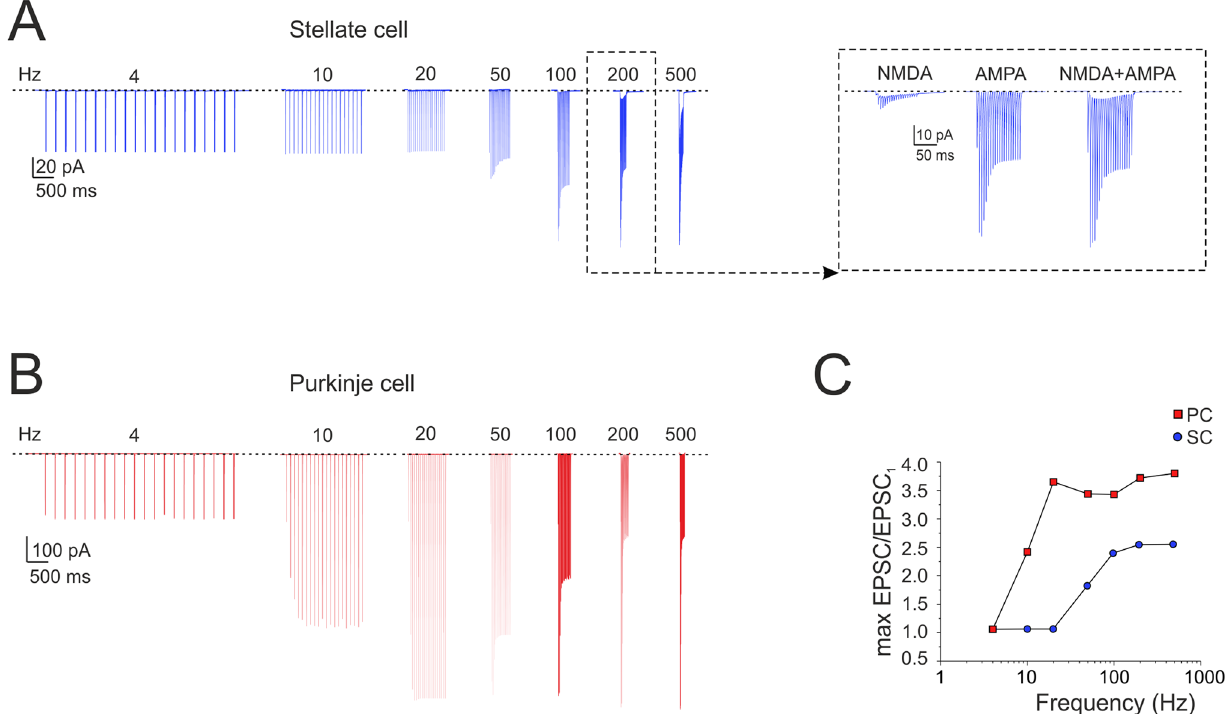
Figure 5. Burst currents at PF-SC and PF-PC cell synapses. (A) The traces show simulated SC EPSCs during trains of 20 stimuli delivered to PFs at different frequencies (4, 10, 20, 50, 100, 200 and 500 Hz; n = 4). Inset, NMDA, AMPA and NMDA + AMPA currents at 200 Hz. (B) The traces show simulated PC EPSCs during trains of 20 stimuli delivered to PFs at different frequencies (4, 10, 20, 50, 100, 200 and 500 Hz). (C) Gain curve for SC (blue circles; n = 4 for each frequency) and PC (red squares) responses with respect to input burst frequency. Gain is the ratio between the maximum response obtained at a certain frequency and the first EPSC. The gain curves show a sigmoidal shape with 50% amplitude around 50 Hz for the SC and around 10 Hz for the PC. Data in C corresponds to the cells in A and